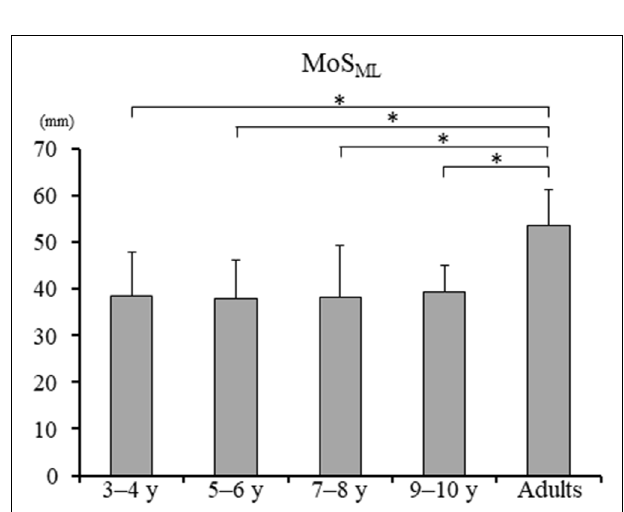
FIGURE 5 | Mean margin of stability in mediolateral axis [MoS ML ; ± standard deviation (SD)]. ∗ , Significant differences p < 0.05.